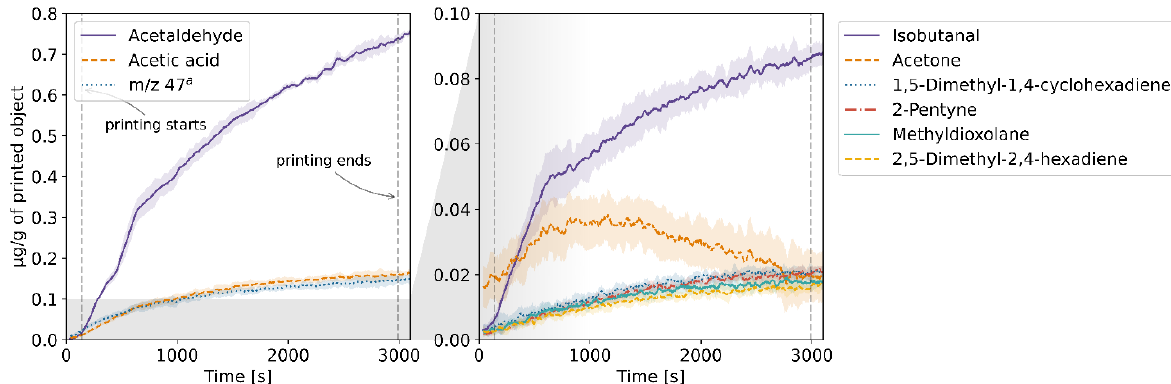
Figure 7. Temperature-dependent emission profile of the PETG filament. a unidentified, possibly formic acid; k = 1.99 × 10 −9 cm 3 s −1 .